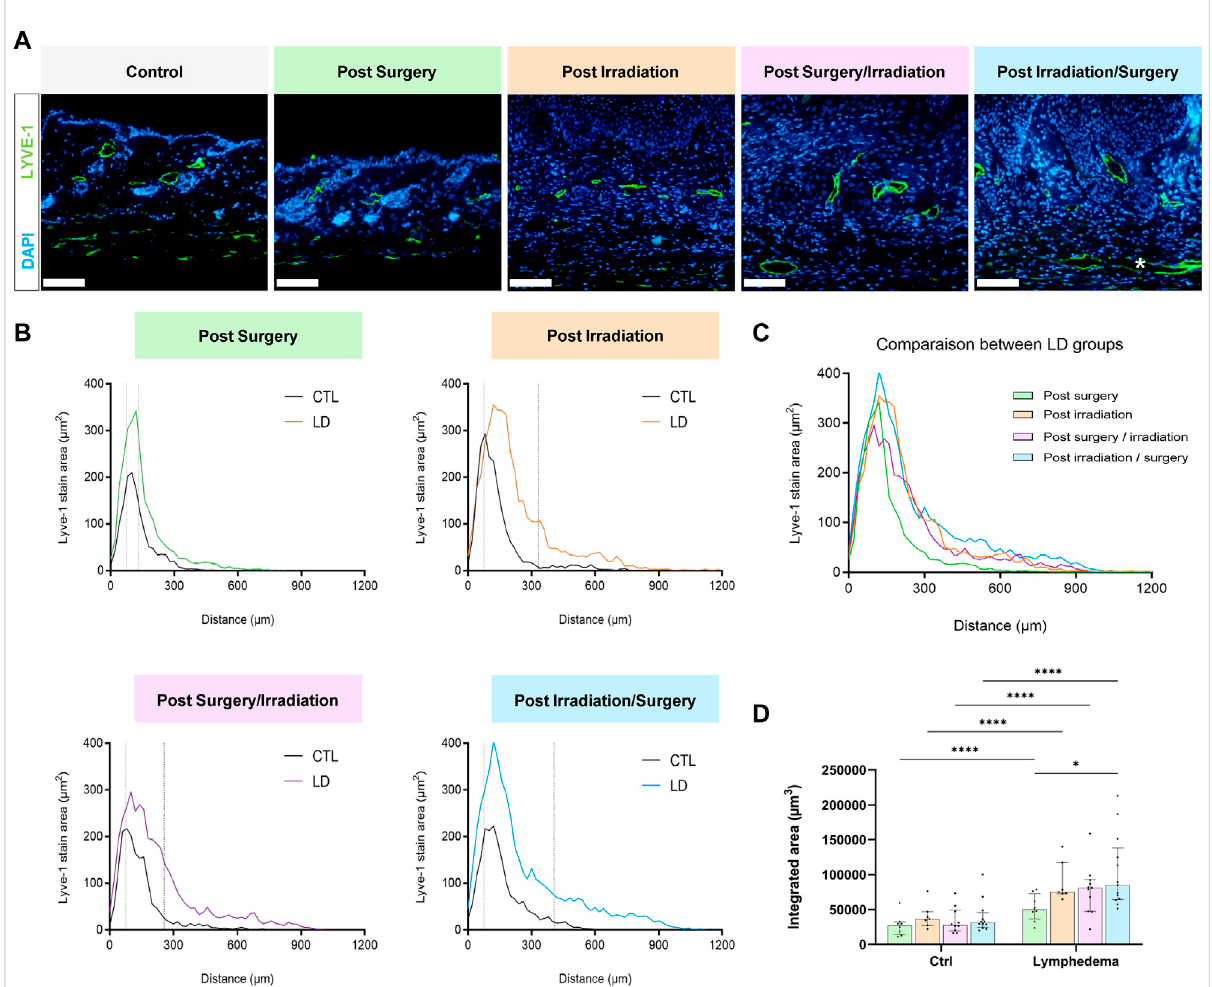
FIGURE 3 Impactoftheproceduresonlymphaticvasculature. (A) RepresentativeimagesofLyve-1positivevesselsincontrolandLDskins.*Whiteasterisk highlights large lymphatic vessels in the reticular dermis (Scale bar: 100 µm). (B) Spatial distribution of Lyve-1 positive lymphatic vessels within the dermis, 0 on the x -axis corresponds to the junction between dermis and epidermis. The dotted line delineates the junction between papillary (PD) andreticular(RD)dermis. (C) Comparisonoflymphaticvesseldistributioncurvesbetweenthedifferentexperimentalgroups. (D) Quanti fi cation of total labeling area in the dermis determined by measuring the area under the distributions curve ( “ Integrated Area ” ) (Statistical test: two-way ANOVA with multiple comparison Turkey ’ s test, p < 0.05: *, p < 0.01: **, p < 0.001: ***, p < 0.0001: